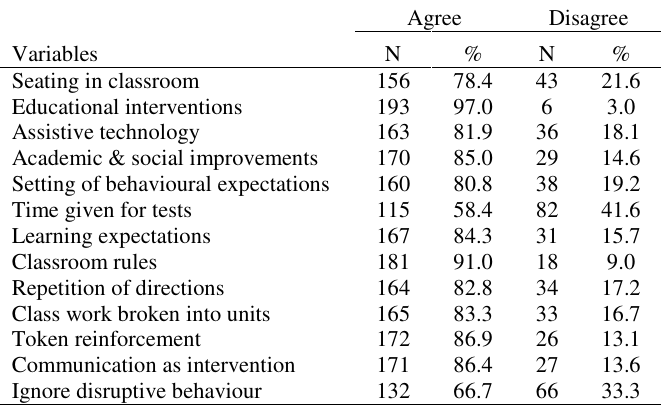
Table 4 Perception of classroom management